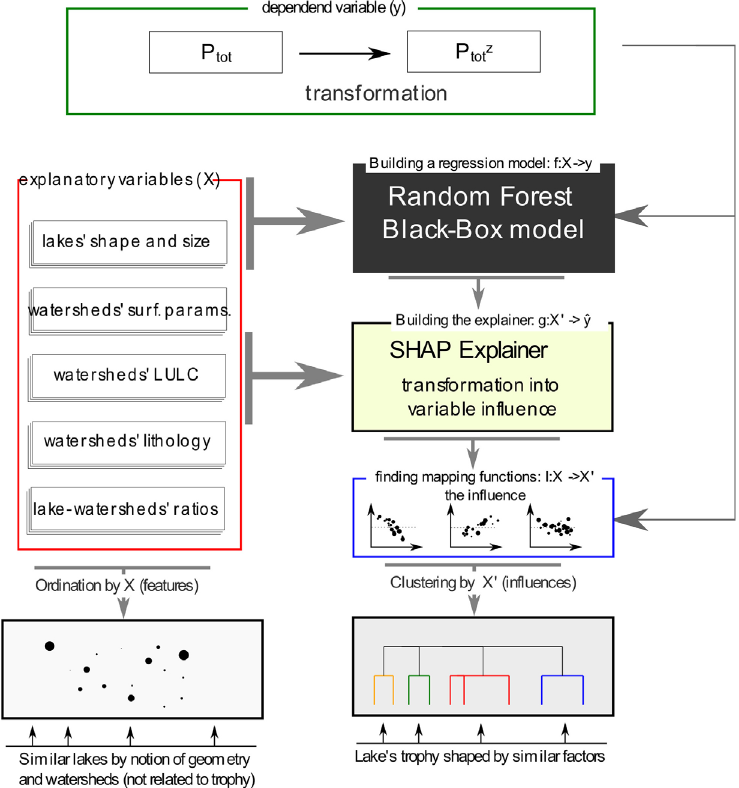
Fig. 3. The outline of methodology. See Section ‘Methods’ for